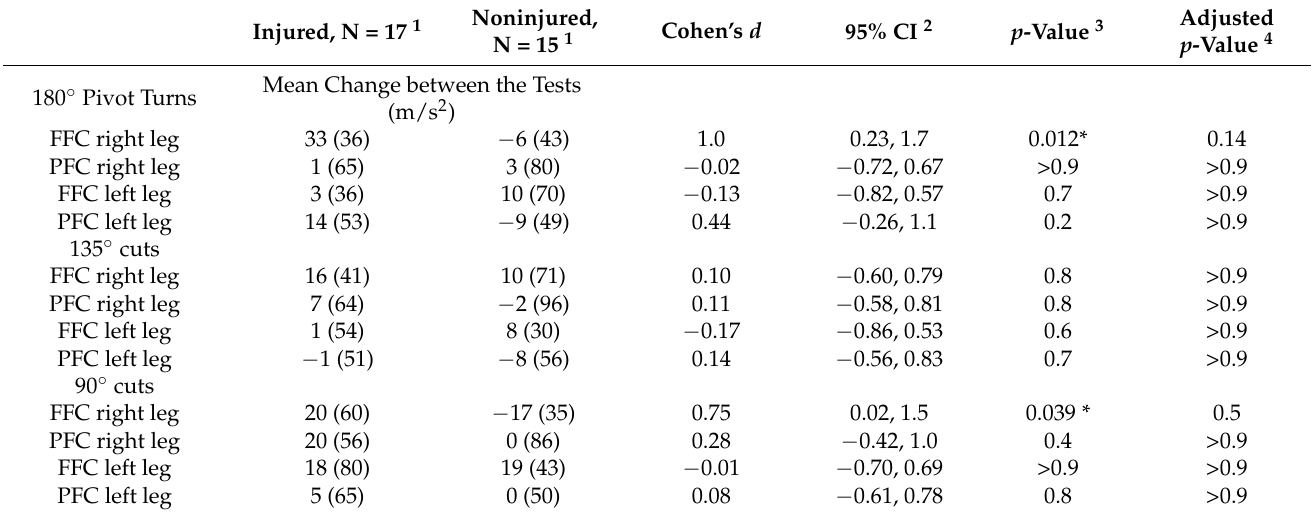
Table 2. Response feature analysis (mean changes) for peak resultant acceleration in all CODs.